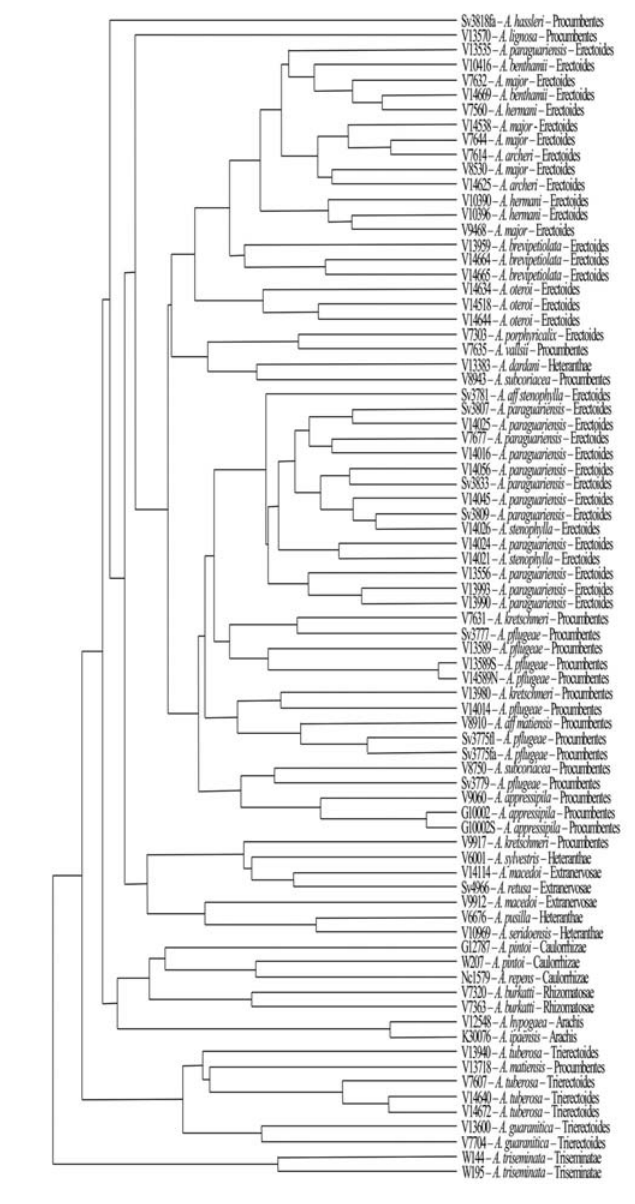
Figure 2 - Dendrogram based on Nei’s genetic distance (1972) for 74 dif- ferent accessions of 33 species of the genus Arachis using 15 micro- satellite